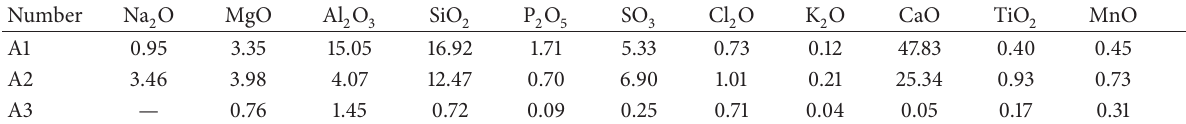
Table 2: Chemical composition of industrial wastes (wt.%).